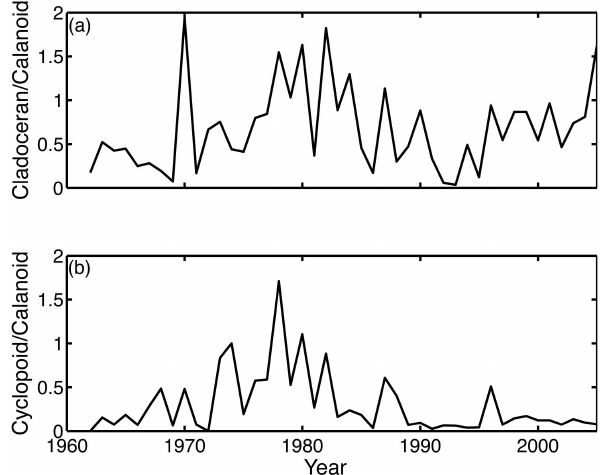
Fig. 7. Time series of the abundance ratio of (a) cladoceran/calanoid and (b)